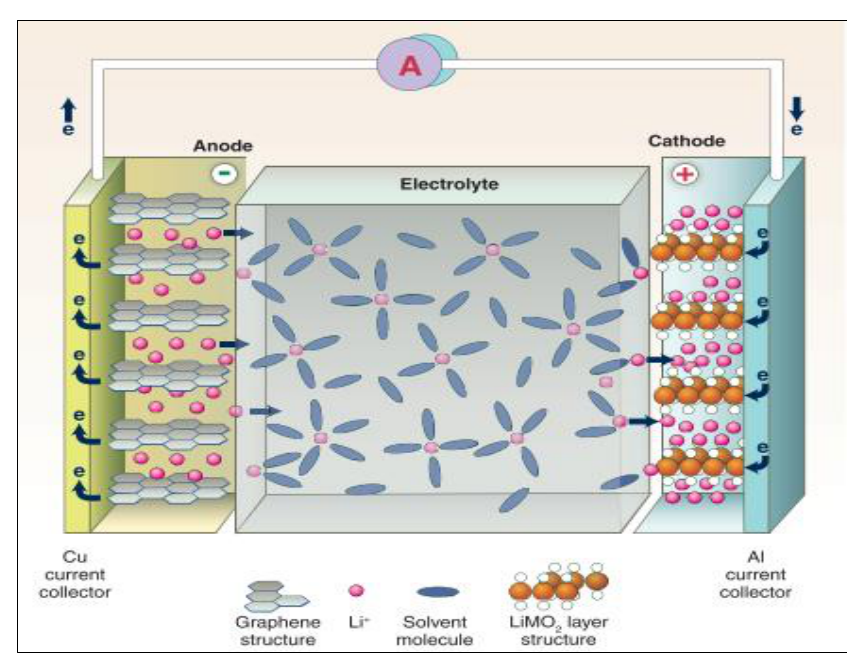
Figure 3: Schematic of Li-ion battery during